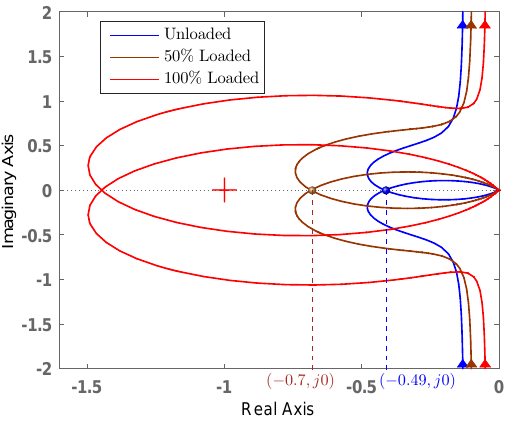
Figure 8. Nyquist diagram of the LRC loop gain ( T S ) for the original controller for three loading conditions, where it encircles ( 1, j 0) at 100% −